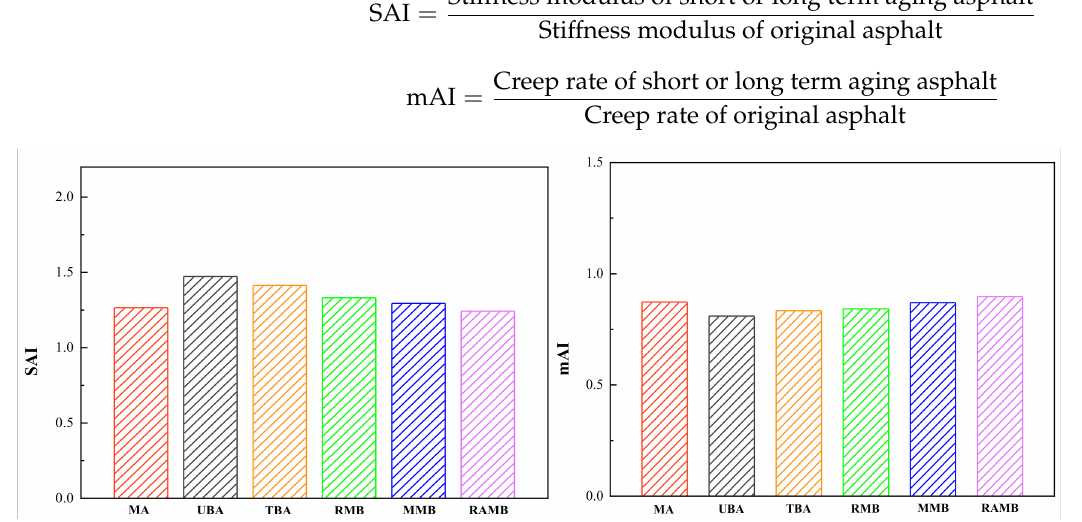
Figure 14. Short-term aging SAI and mAI for six asphalts.